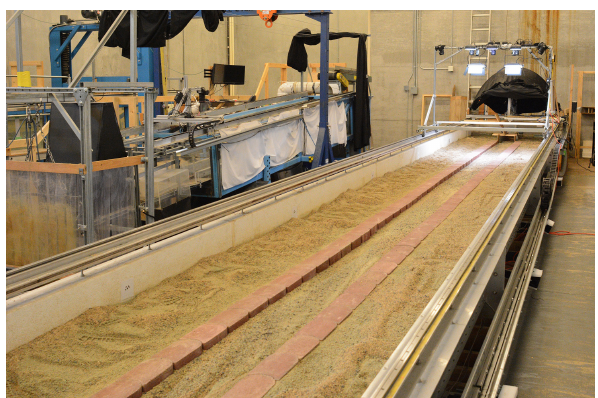
Figure 2. Adjustable-Boundary Experimental System (A-BES) at the University of British Columbia, showing the camera rig and the 30cm wide channel